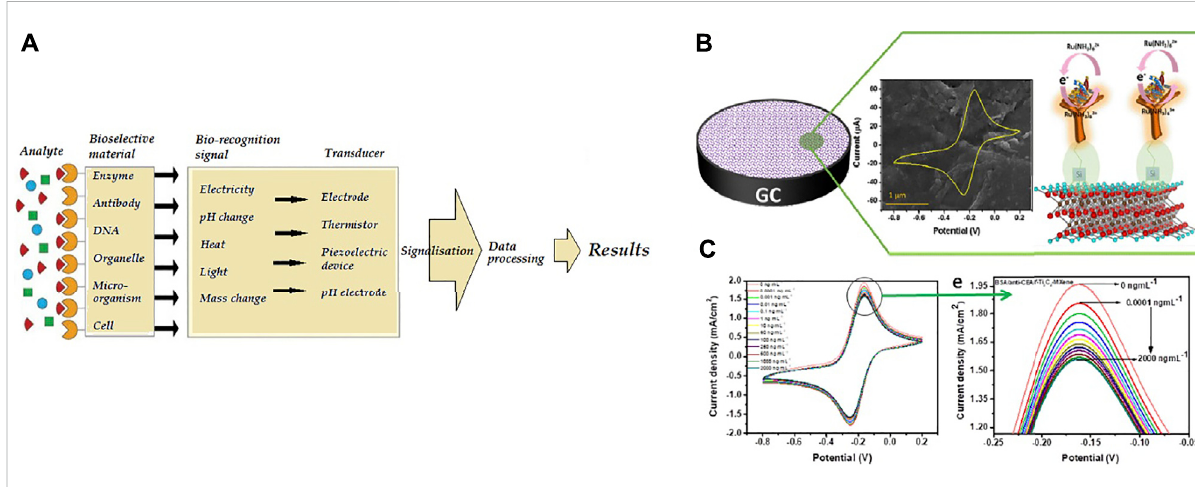
FIGURE 2 (A) Thebiosensorprocessesprinciple(Kivirandetal.,2013) (B) Schematicoftheelectrochemicalbiosensor(BSA/anti-CEA/f-Ti 3 C 2